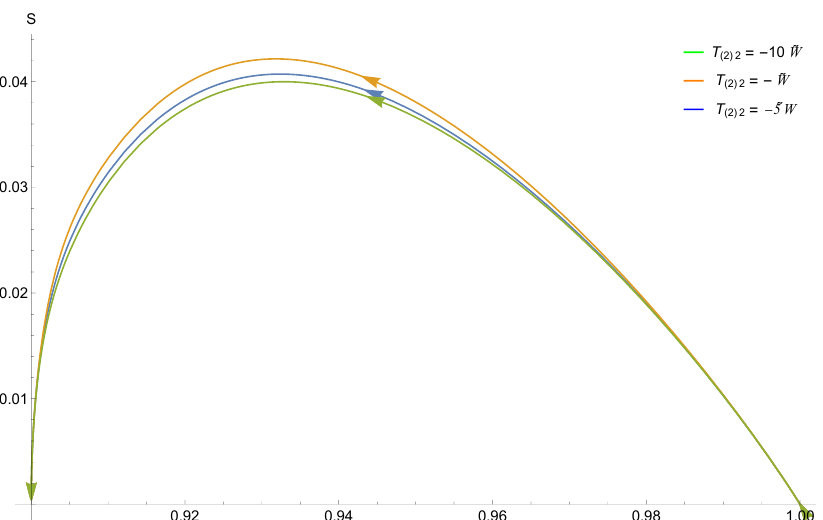
Figure 15 . Plot of the superpotential S as a function of ϕ for different choices of α , for Bolt end-point solutions. The IR endpoint for this plot has been chosen to be at ϕ of the flow is indicated in the figure: it starts from the UV fixed point and ends at the IR. The different lines correspond to different choices of the integration constant T defined in